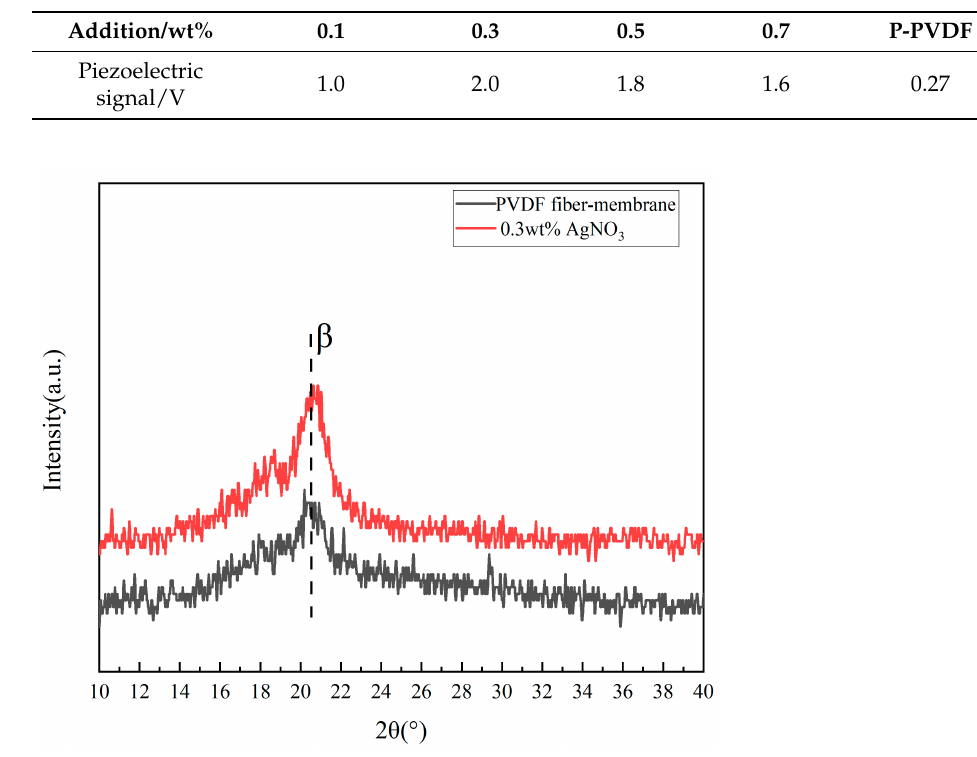
Figure 11. XRD patterns of the P-PVDF fibers membrane and PVDF/AgNO 3 fiber membrane at the addition of 0.3 wt% AgNO 3. addition of 0.3 wt% AgNO 3 .